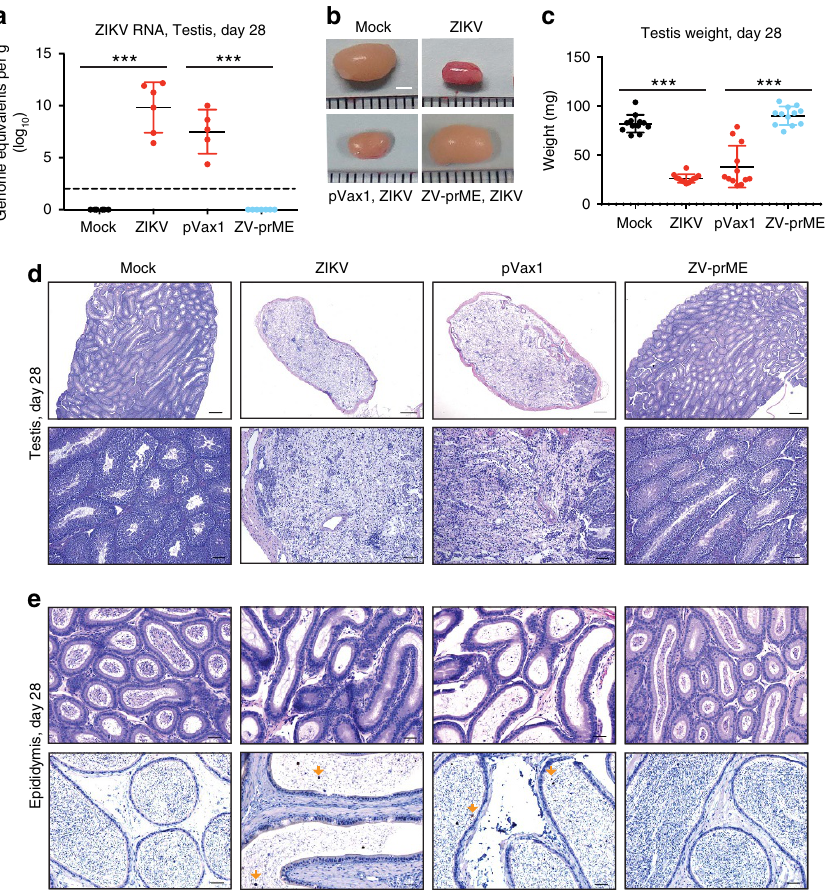
Figure 3 | Protection from ZIKV-induced damage to the testis and epididymis by DNA immunization. Five- to six-week-old male Ifnar1 (cid:2) / (cid:2) mice received two vaccinations by the i.m. route with electroporation-mediated delivery at 2-week intervals with 25 m g of the control vector (pVax1) or ZIKV-prME DNA vaccine (ZV-prME). Mice were challenged 2 weeks after the second immunization with a total of 1 (cid:3) 10 6 p.f.u. of ZIKV strain PRVABC59 by a subcutaneous route (s.c.) and compared to age-matched PBS mock-infected (mock) or ZIKV-infected mice (ZIKV). The testes and epididymides were collected at 28 d.p.i. ( a ) ZIKV RNA copies in the testis of mice measured by qRT-PCR ( n ¼ 5 or greater). Results are expressed as genome equivalents per gram of tissue. The horizontal hatched line indicates the limit of detection ( o 100 copies per ml). ( b ) Representative images of testis. ( c ) Weight of the testis (2 per mouse). ( d ) Histopathological analysis of the testis. ( e ) Immunohistochemical labelling of ZIKV particles in the epididymis. Arrows indicate cells positive for ZIKV antigen. Scale bars, 2mm in ( b ), 200 m m in ( d , top panel), 50 m m in ( d , lower panel), 50 m m in ( e , top panel), 10 m m in ( e , lower panel). The data shown are from one experiment ( n ¼ 6) that is representative of the same outcome in the two studies performed. Bars indicate mean values and error bars indicate s.d. Statistical differences are given (two-way ANOVA followed by the Bonferroni post-test). *** P ¼